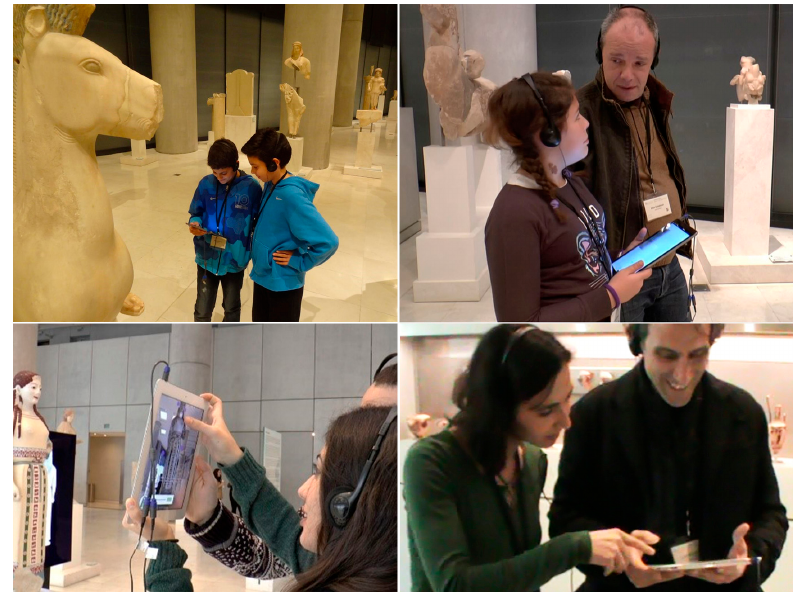
Figure 6. Social interaction is limited by the need to wear headphones but visitors adopted non-verbal methods and body language strategies to communicate and share the experience.